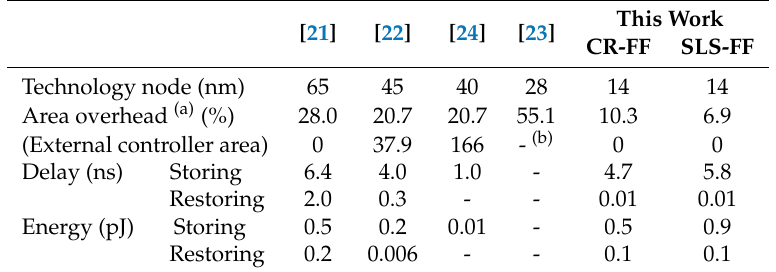
Table 2. Performance summary and comparison with the state-of-the-art